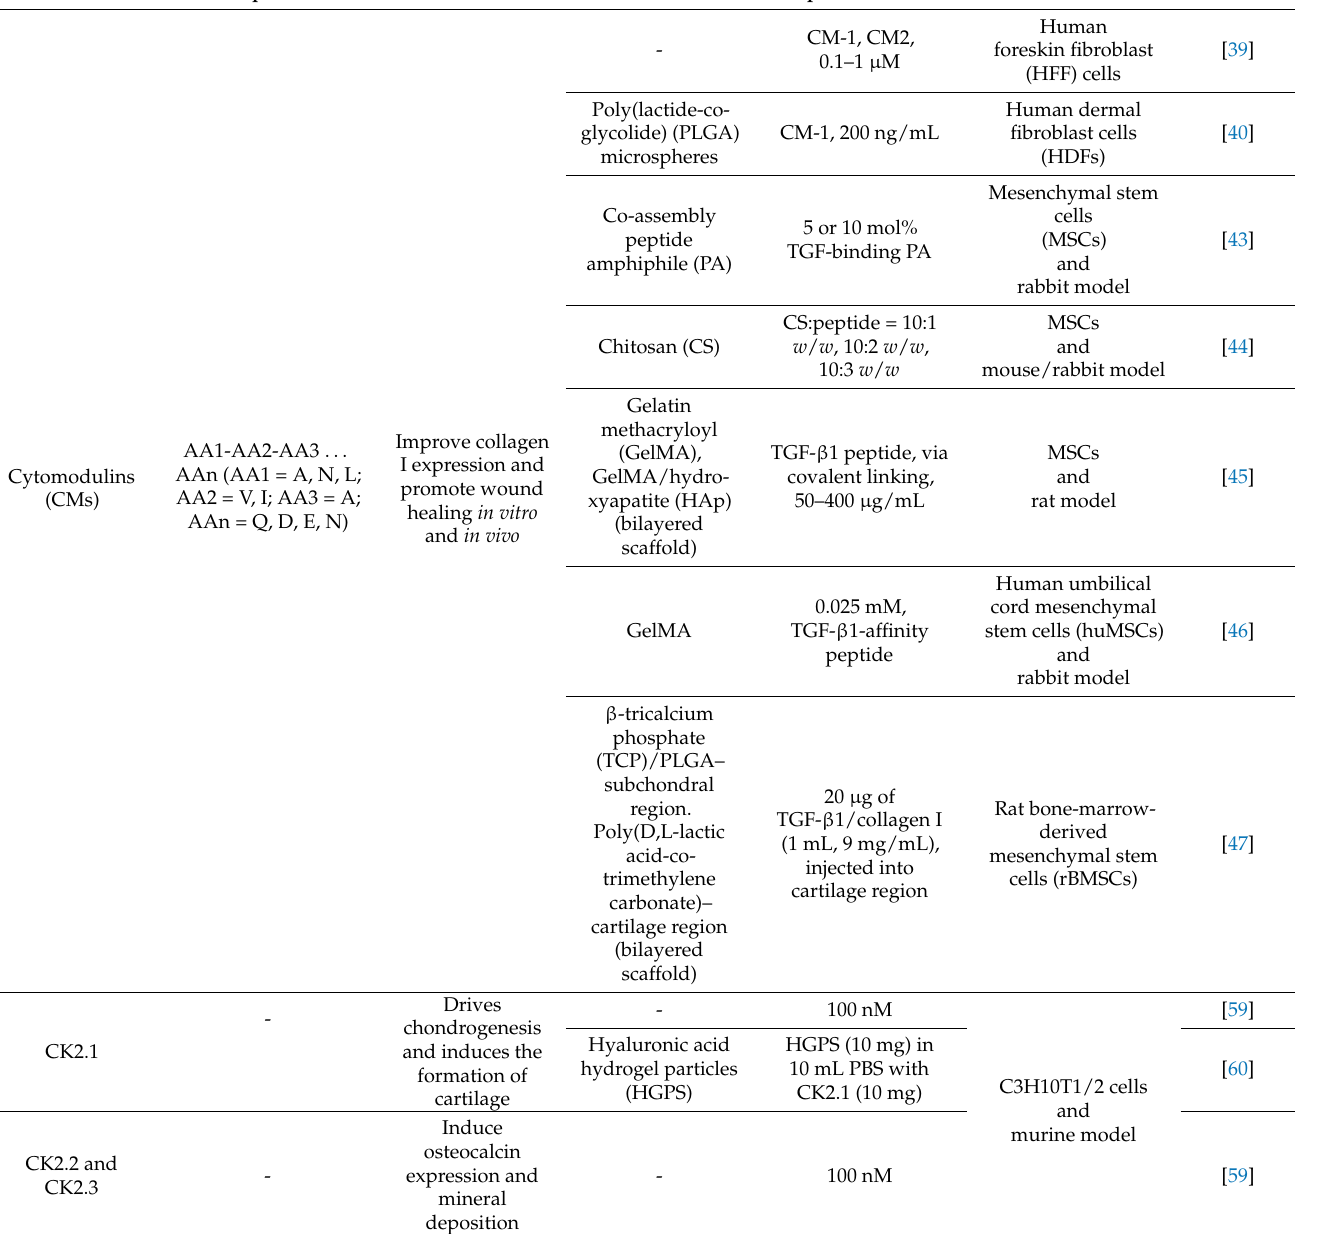
Table 1. List of the peptides involved in